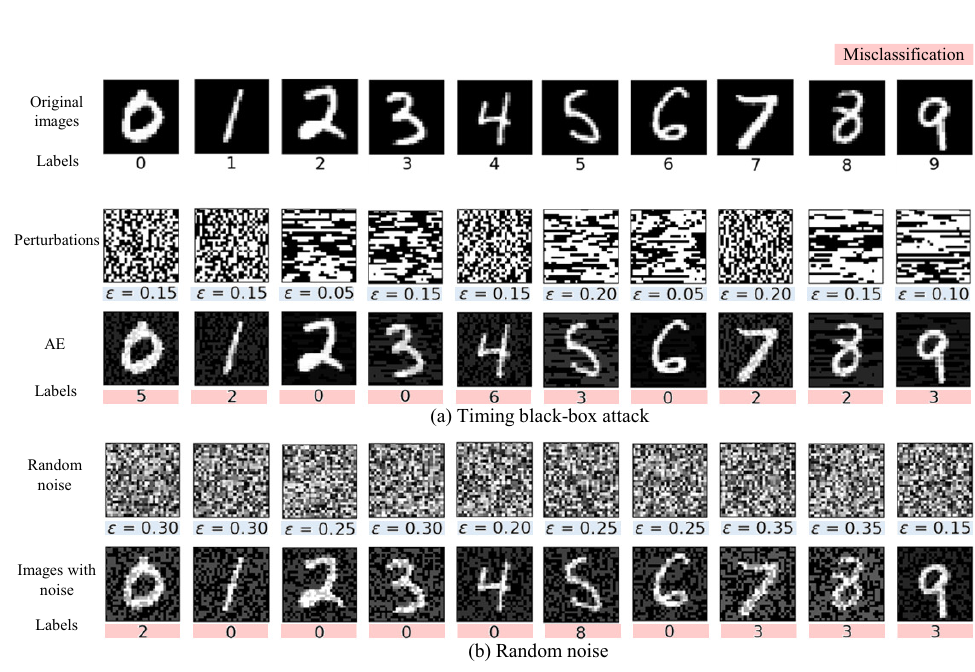
Figure 11: AEs crafted by proposed attack and random noise against MLP model on MCU. Original images are shown in first row, and attack results are presented in second (perturbations) and third (AEs) rows. Random noise results are shown in fourth (random noise) and fifth (images with noise) rows. Perturbation bound, ε , and misclassification labels are shown in the